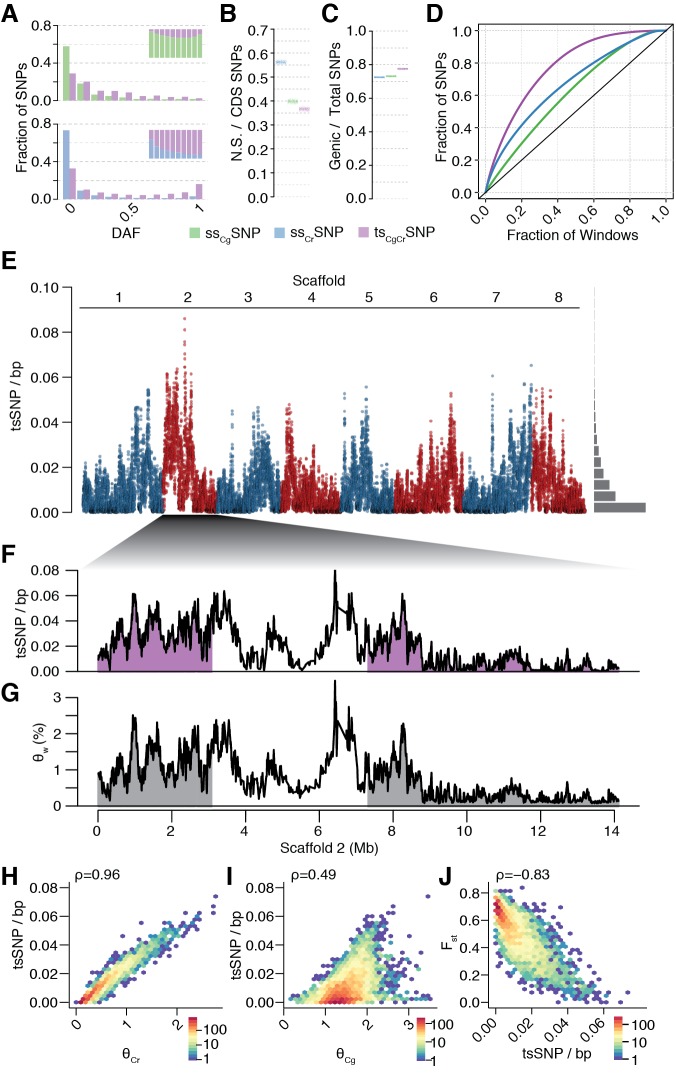
Unequal presence of ancestral variation in modern C.rubella.(A) Derived allele frequency spectra (DAF) of ssCgSNPs (green), ssCrSNPs (blue), and tsCgCrSNPs (purple) in C. grandiflora (top) and C. rubella (bottom). The inset depicts the fraction of alleles that are species or transpecific as a function of derived allele frequency (DAF). (B) Fraction of coding (CDS) SNPs that result in non-synonymous changes as a function of SNP sharing. (C) Fraction of genic SNPs as a function of SNP sharing. Because SNPs in different classes (ssSNPs, tsSNPs) differ in allele frequency distributions, we normalised by downsampling to comparable frequency spectra. Each bar consists of 1000 points depicting downsampling values. (D) 20 kb genomic windows required to cover different fractions of ssSNPs and tsSNPs. The black line corresponds to a completely even distribution of SNPs in the genome. tsSNPs deviate the most from this null distribution. (E) tsCgCrSNP density in 20 kb windows (5 kb steps) along the eight Capsella chromosomes. Histogram on the right shows distribution of values across the entire genome. (F) tsCgCrSNP density and (G) Watterson’s estimator (Θw) of genetic diversity along scaffold 2. The repeat dense pericentromeric regions are not filled. (H–J) Correlation of tsCgCrSNP density in 20 kb non-overlapping windows with genetic diversity in C. rubella (H), genetic diversity in C. grandiflora (I), and interspecific Fst (J). Spearman’s rho is always given on the top left. Only windows with at least 5000 accessible sites in both species were considered.